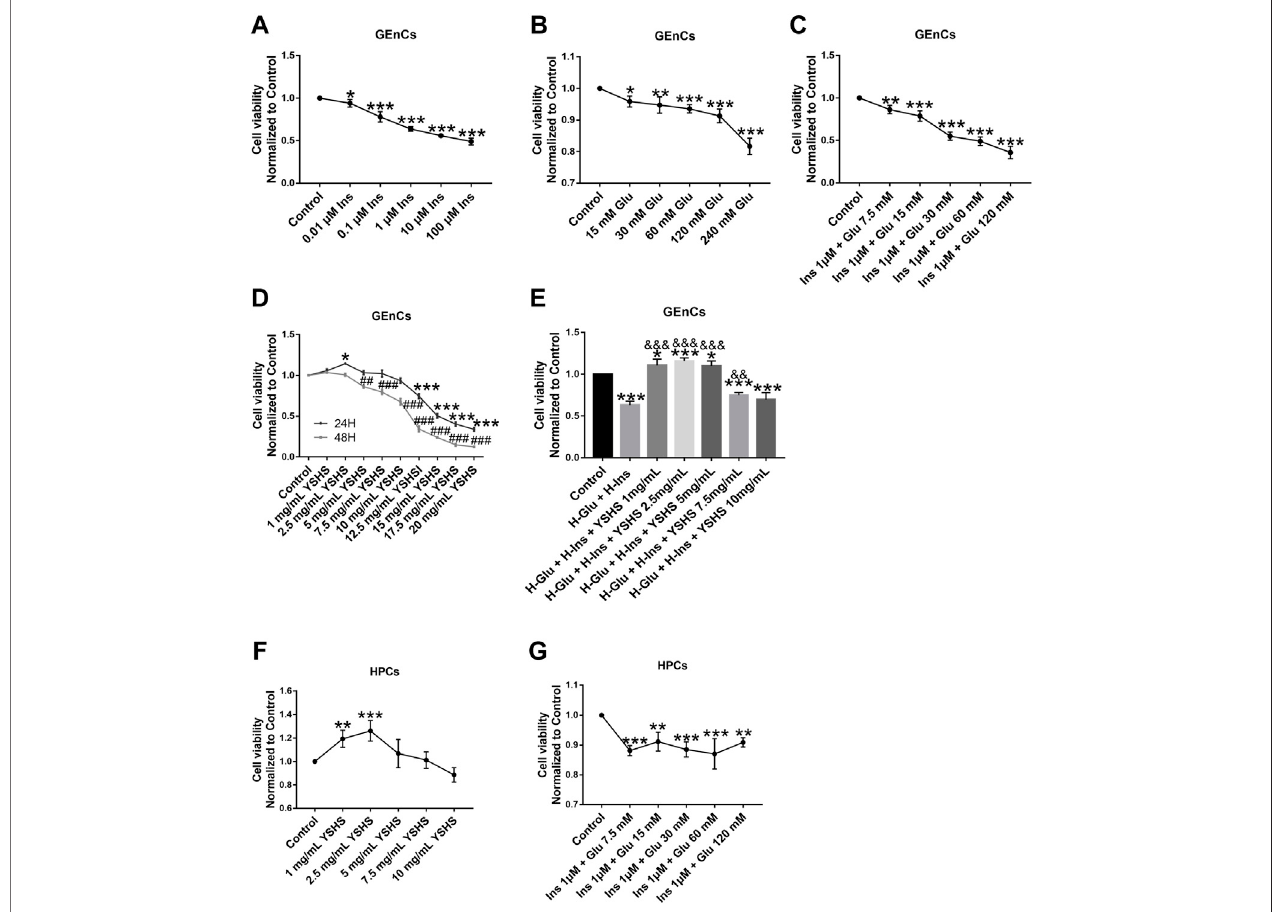
FIGURE 7 | In fl uence of YSHS on viability of the GEnC and HPC cells. Viability analysis of GEnCs on drug administration (A – E) ; viability analysis of HPCs on drug administration (F,G) . Data are expressed as the mean ± SEM. Each experiment was repeated at least three times. (A – C,F,G) * p < 0.05, ** p < 0.01, *** p < 0.001, vs. control. (D) , * p < 0.05, ** p < 0.01, *** p < 0.001, vs. 24 h control; ## p < 0.01, ### p < 0.001, vs. 48 h control. (E) , * p < 0.05, ** p < 0.01, *** p < 0.001, vs. control. (D) , & p < 0.05, && p < 0.01, &&& p < 0.001, vs. H-Glu +